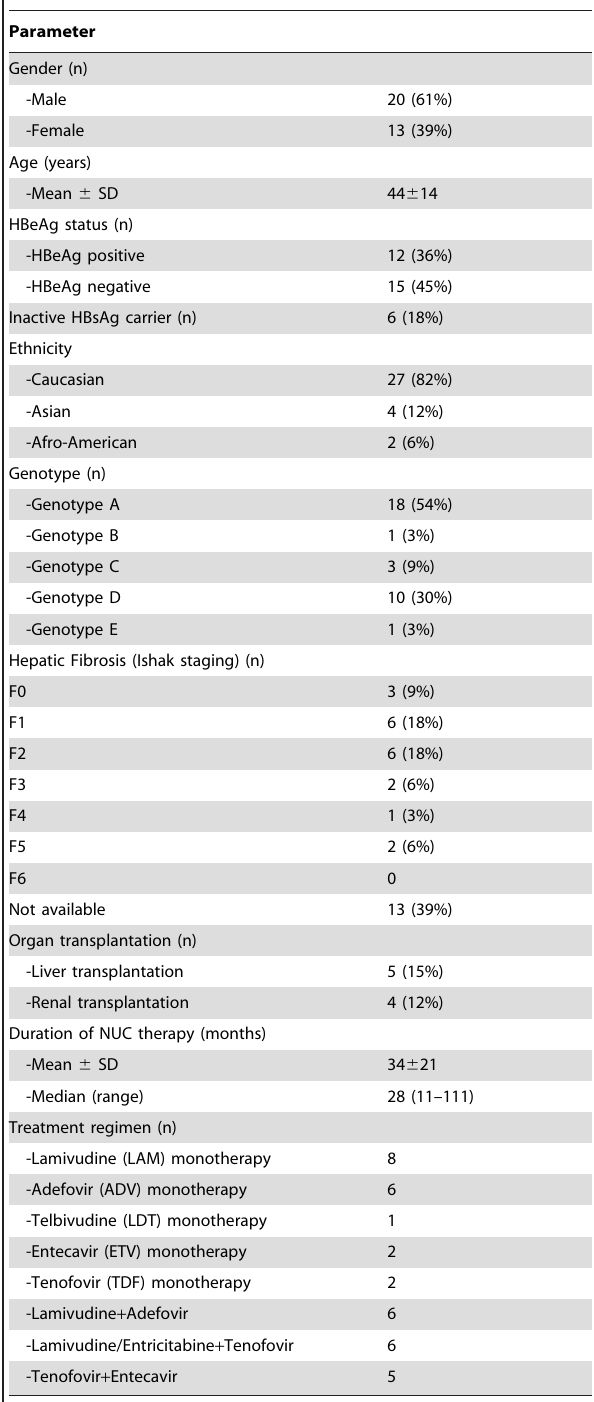
Table 1. Baseline characteristics of the study